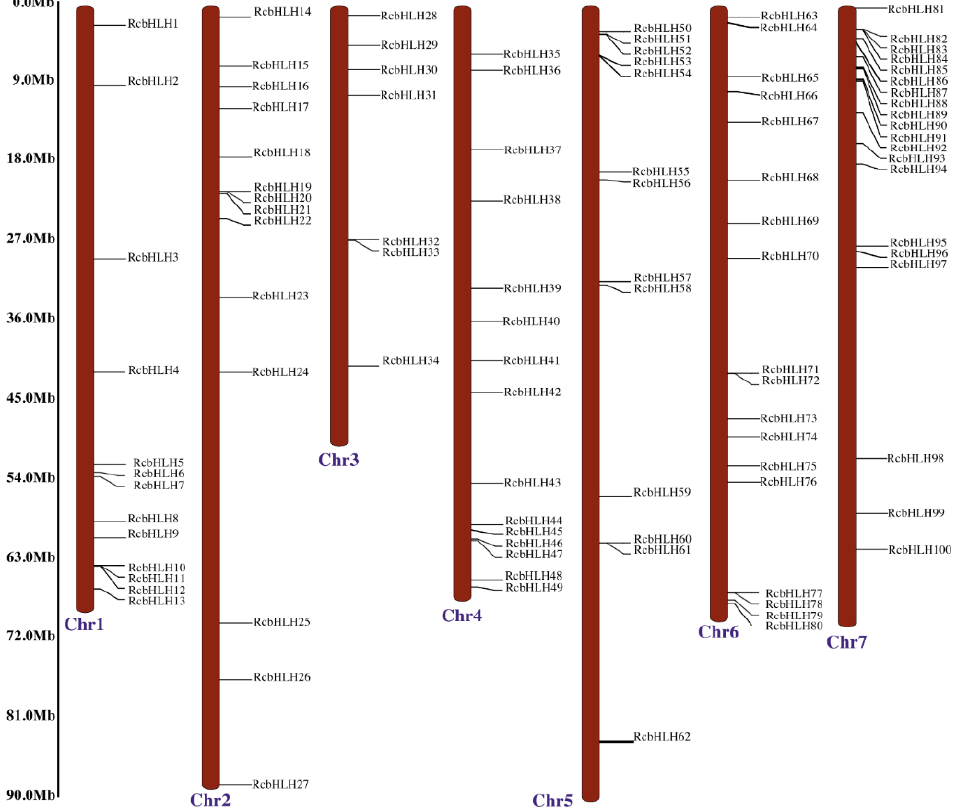
Figure 1. Distribution of RcbHLH s on rose chromosomes. Chr represents the chromosome. The left side of the figure scale was used to represent the chromosome length and position of each RcbHLH member on the respective chromosome.